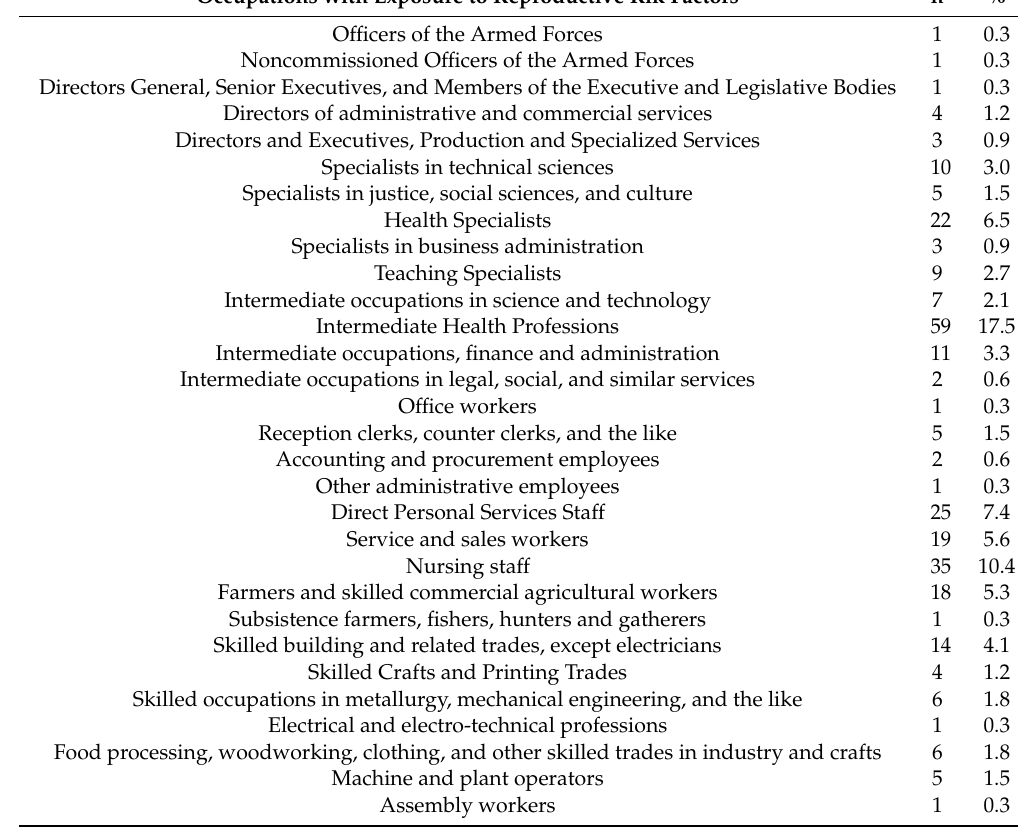
Table 4. Description of the occupations for which exposure to reproductive risk factors was identified for employed patients (n = 579) seen in interviews at the ARTEMIS Center from 16 February 2016 to 1 June